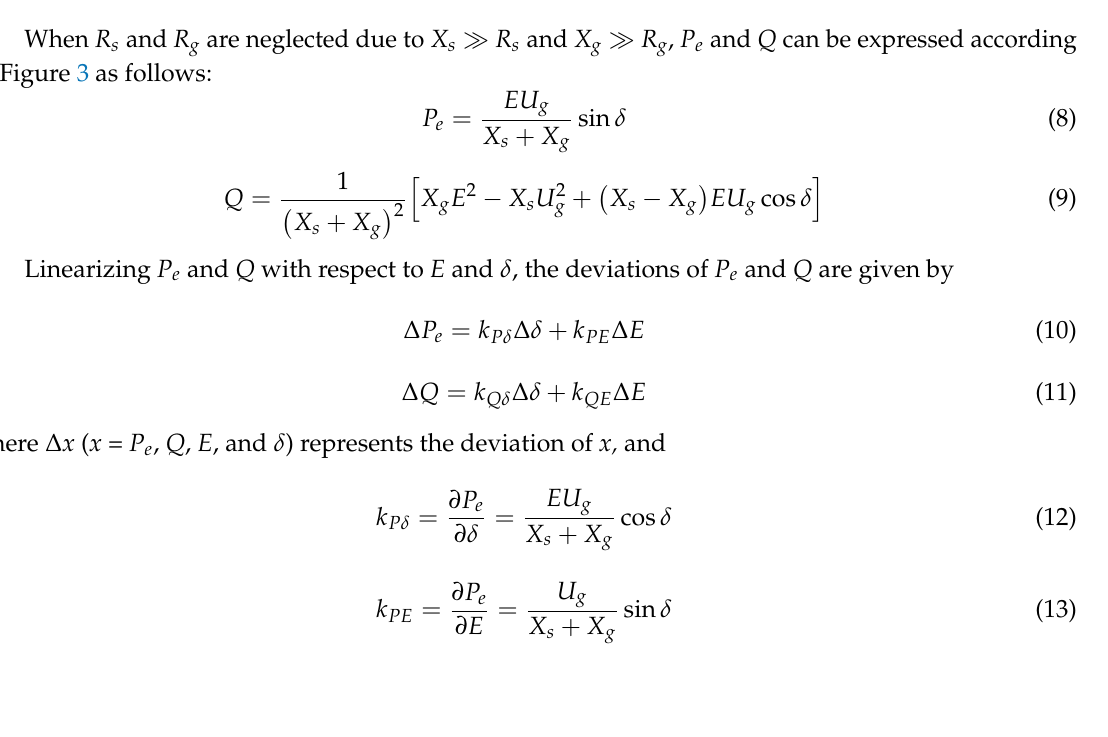
Figure 3. Equivalent circuit of the inverter when connected to the grid.